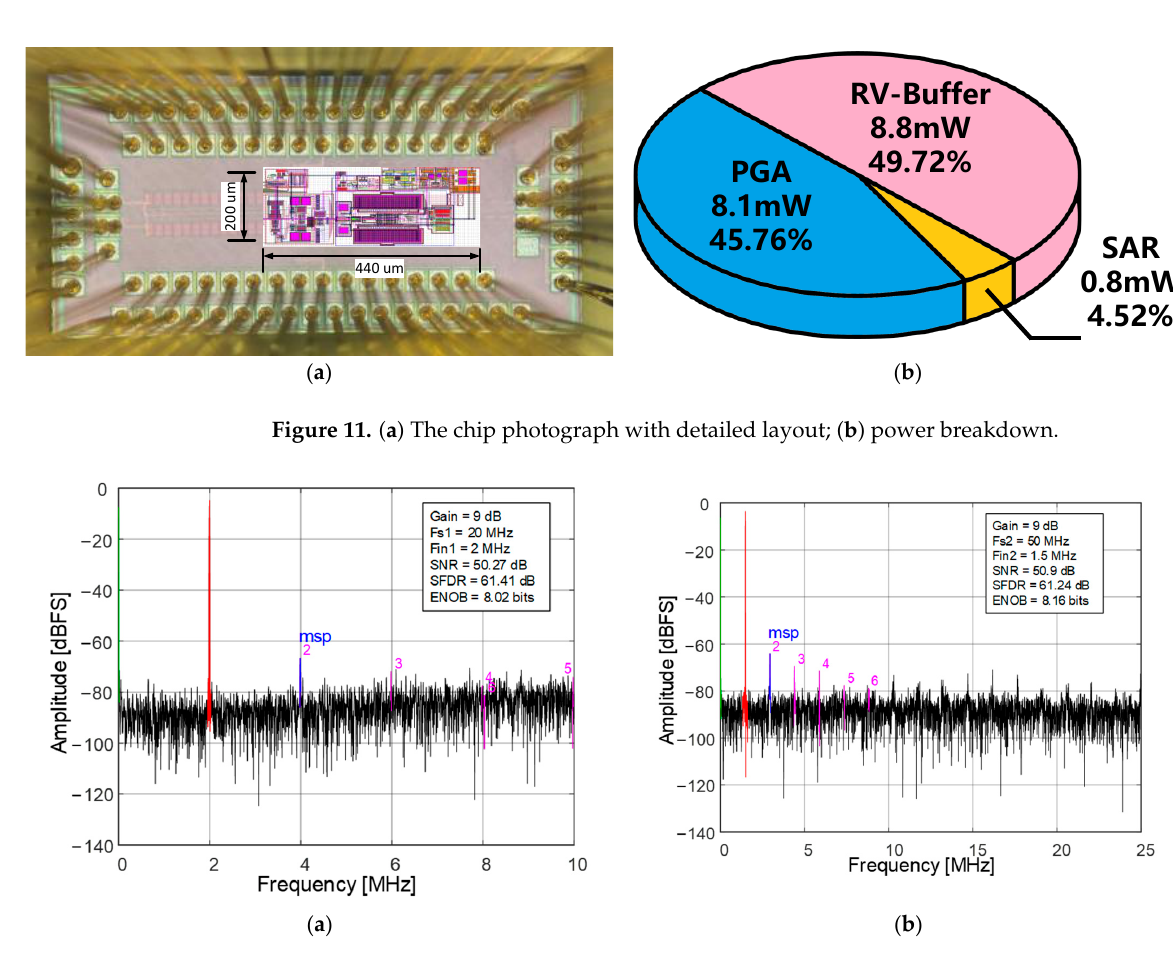
( c ) Figure 10. The simulated spectrum: ( a ) under the ideal situation; ( b ) with parasitic inductance and without RV-Buffer; ( c ) with parasitic inductance and with RV-Buffer. 4. Measurement Results The prototype of the proposed 12 bit SAR ADC with the input PGA and RV-Buffer was implemented in 65 nm CMOS technology. Figure 11a shows the chip photograph and its zoomed-in view of the core layout occupying an active area of 440 µm × 200 µm. The SAR ADC core and input PGA use a 1.2 V supply, while the RV-Buffer uses a 2.5 V supply.